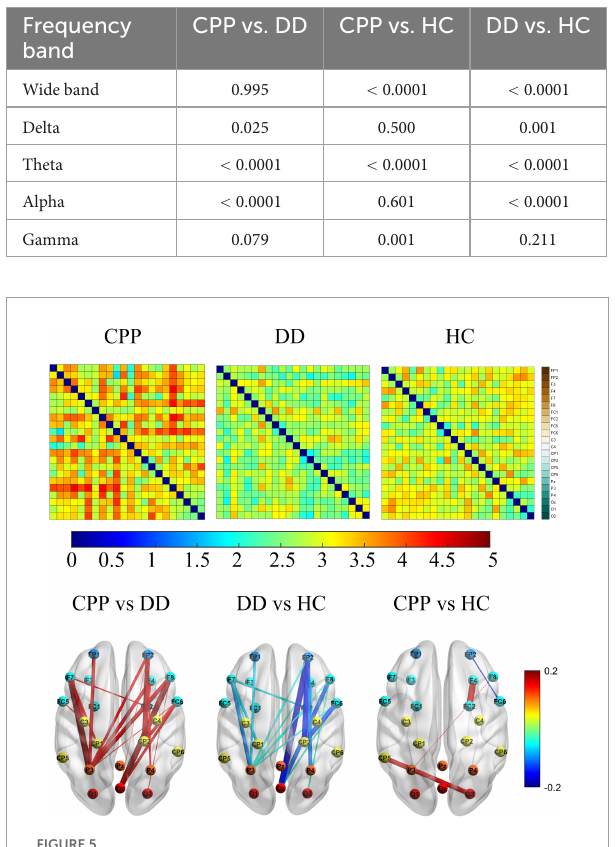
channels from top to bottom are FP1, FP2, F3, F4, F7, F8, FC1, FC2, FC5, FC6, C3, C4, CP1, CP2, CP5, CP6, Pz, P3, P4, Oz, O1, and